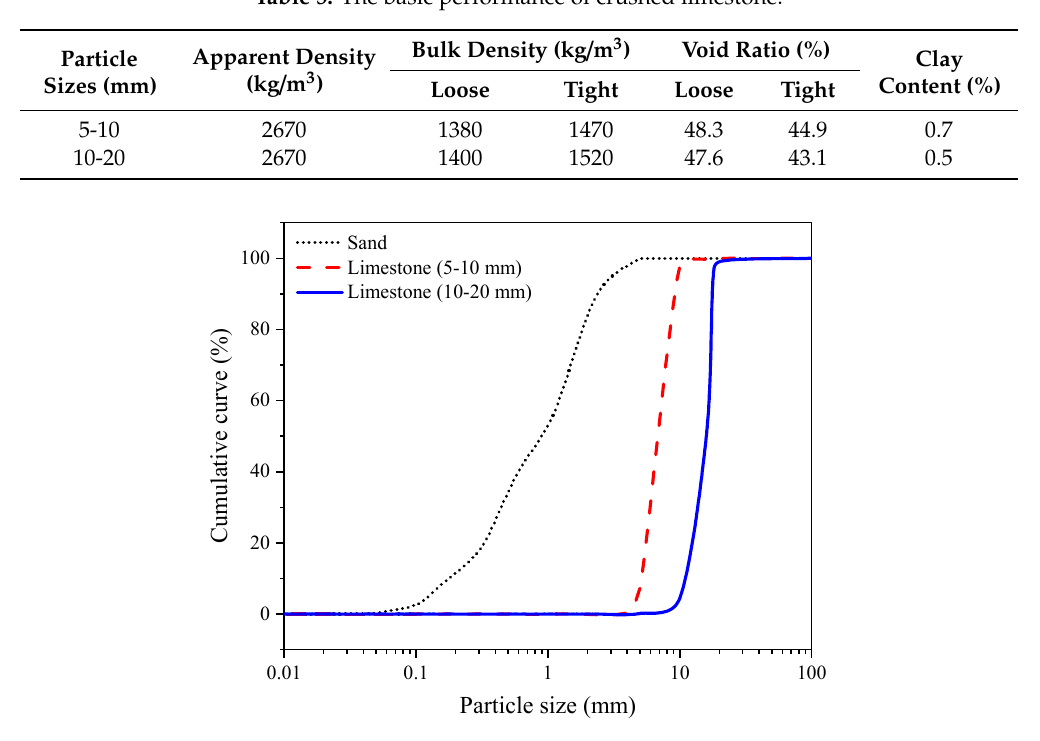
Figure 1. Particles size distribution of sand and crushed limestone.